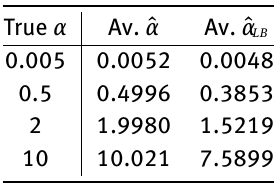
Table 2: Av. estimated dependence parameters ˆ α and ˆ α LB , based on 1000 replicates, for Clayton copula associated with the CDF’s F U ( u , z ) and F LB ( u , z ), respectively, for N = 5000, n = m = 1000, r = 4 and p = 2 .